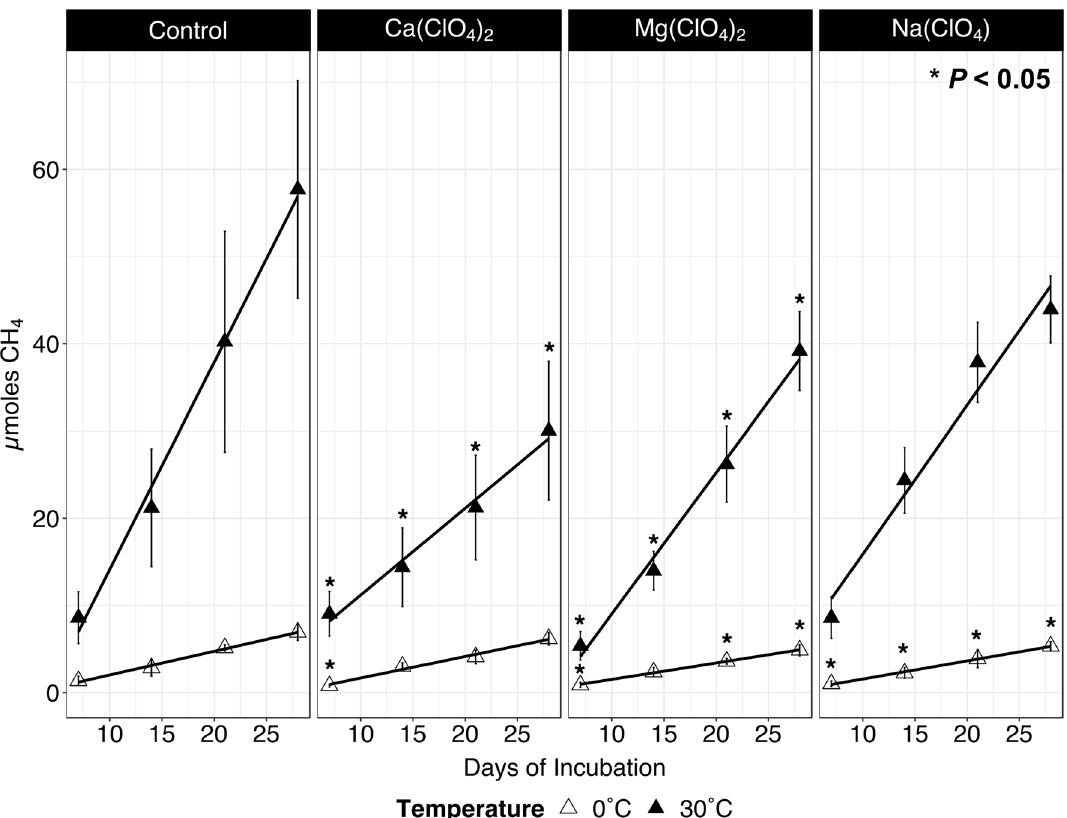
Figure 2. Cumulative CH 4 production by M. barkeri strain MS (from left to right) in media without perchlorate (Control), Ca(ClO 4 ), Mg(ClO 4 ) 2 , or Na(ClO 4 ) at 30 °C (filled triangles) and 0 °C (open triangles). Statistically significant differences in CH 4 production in perchlorate-supplemented incubations relative to the control of the same temperature are indicated by asterisks (*) (paired t-test, P <